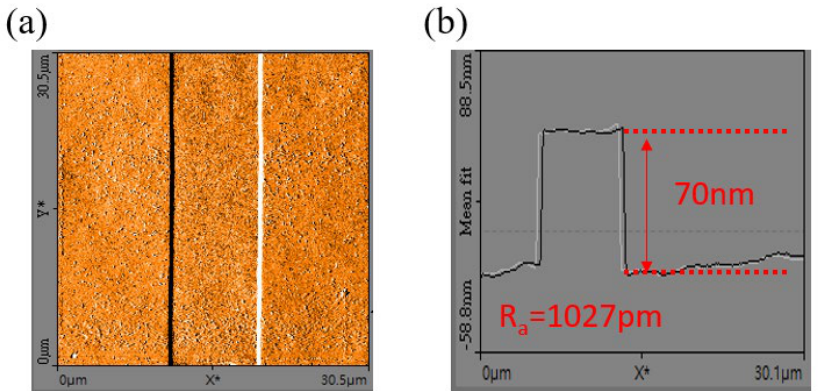
Figure 2. ( a ) Atomic force microscopy (AFM) image of the p-GaN gate region. ( b ) The depth pro-